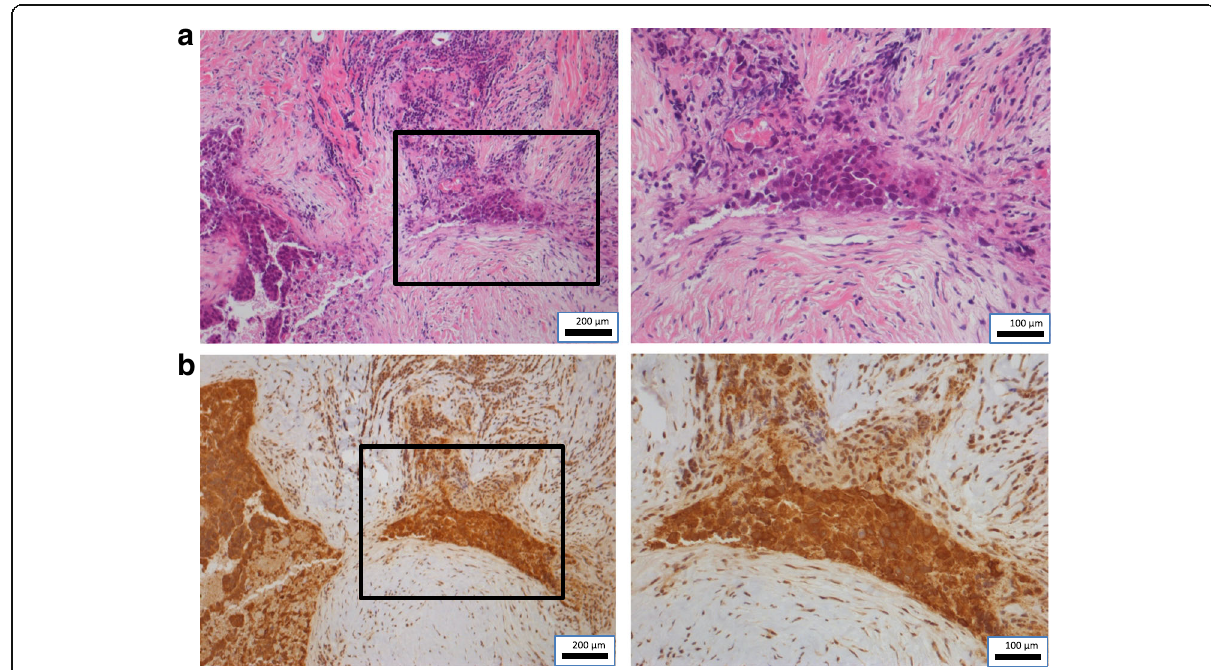
Fig. 6 Representative hematoxylin – eosin-stained images and MUC-1 immunohistochemistry results in disseminated nodule specimen. a Disseminated tumor cells. Right: × 200; left (insert): × 100. b MUC-1 expression of disseminated tumor cells. Brown chromogen: MUC-1 + cells. Right: × 200; left (insert): ×